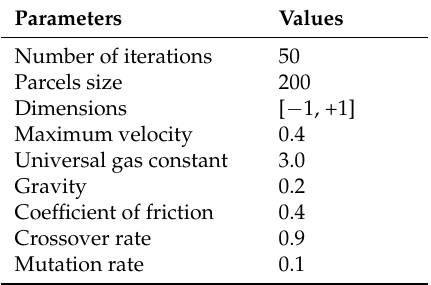
Table 8. Parameters of